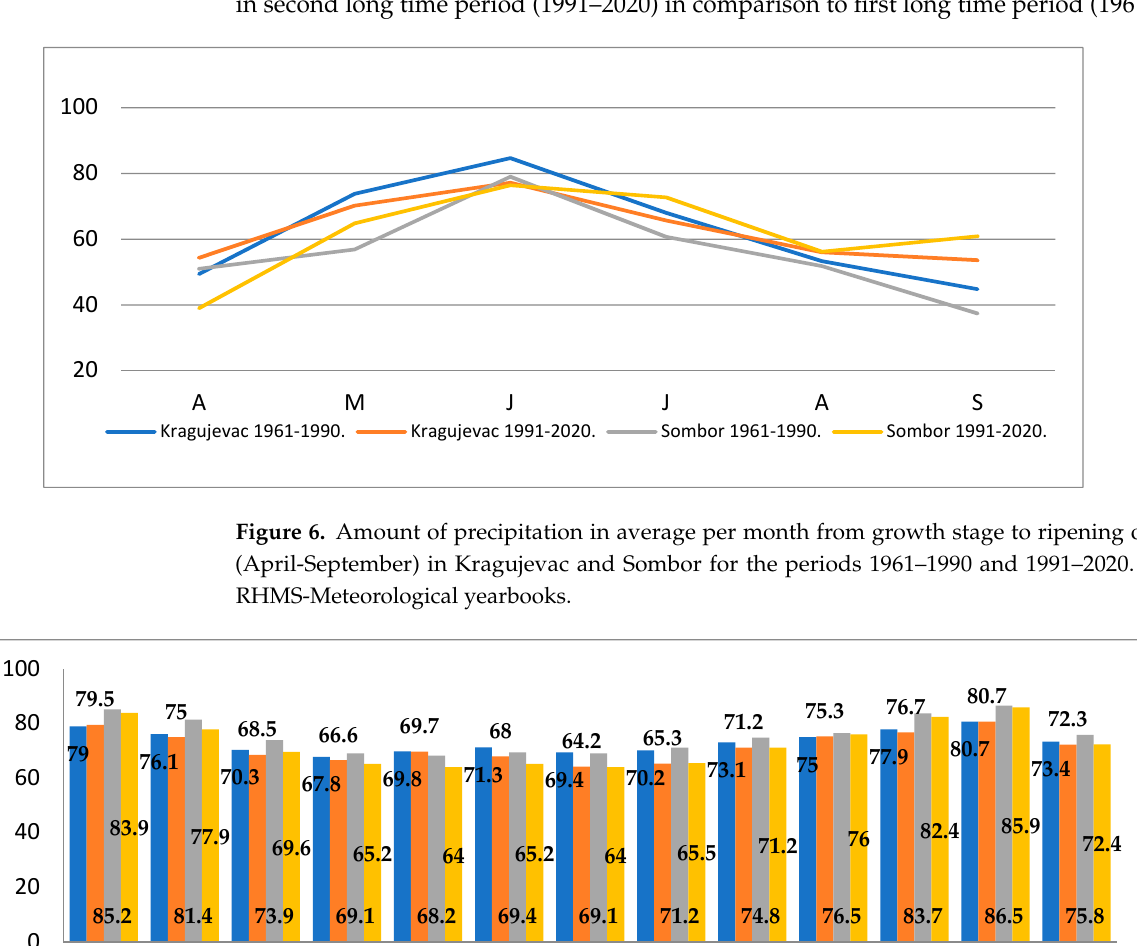
Figure 7. Annual average monthly values of relative humidity (Januar-December) in Kragujevac and Sombor for a period of time 1961–1990 and 1991–2020. Source: RHMS-Meteorological yearbooks.